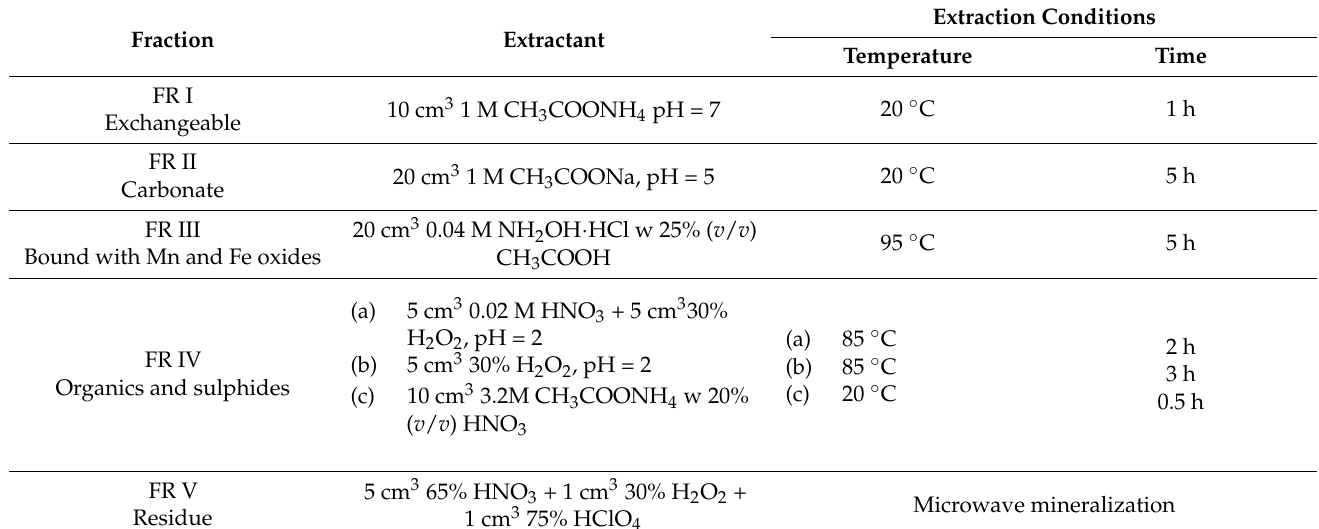
Table 4. Analytical procedure (adapted with permission from